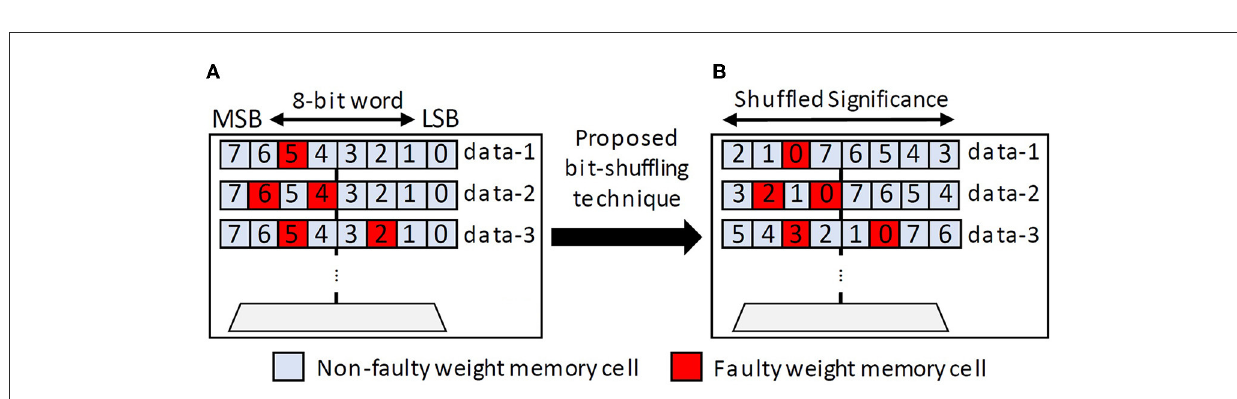
FIGURE9 (A) Illustration of possible fault locations (fault map) in faulty weight registers. (B) The proposed circular-shift bit-shuffling technique for the corresponding fault map.